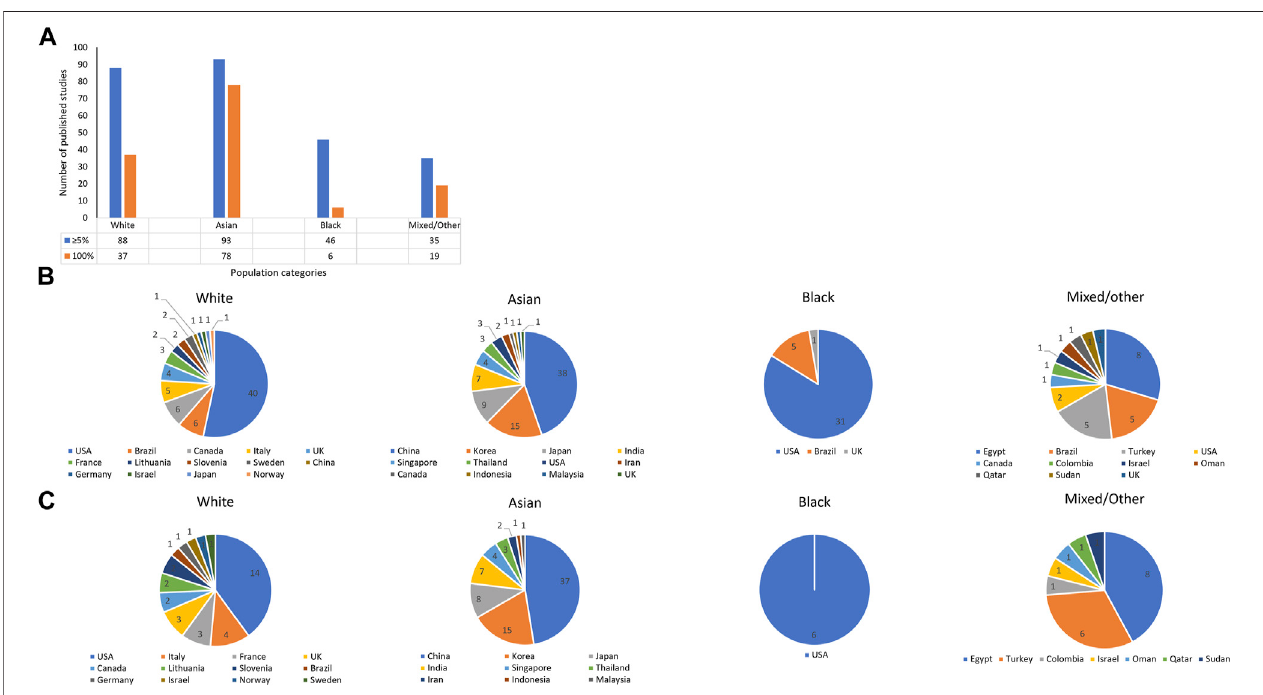
FIGURE 2 | Number of pharmacogenomic studies that developed dosing algorithms as of 20 May 2020. A shows the number of pharmacogenomic studies that included at least 5% or 100% of a population category. On the other hand, B, C show the country-breakdown per population category with B corresponding to the 5% cut-off and C , the 100% cut-off. As recruitment was not strati fi ed by location/country, studies that recruited from multiple countries are excluded in B, C .